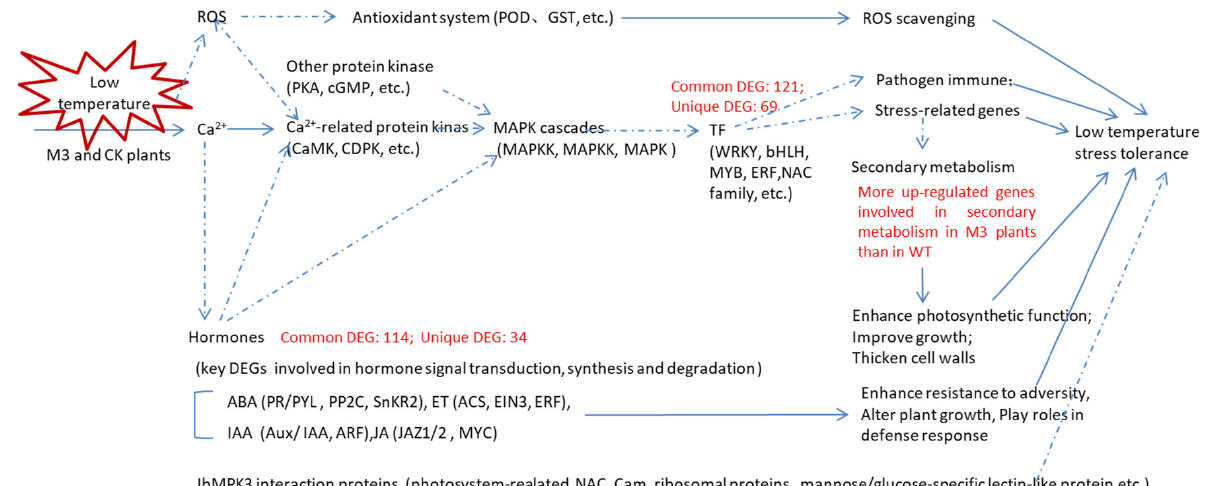
Figure 12. Hypothetical schematic model showing the mechanism in WT and M3 plants against low-temperature stress. This model was developed by combining the results of the RNA-seq analysis with previously described schemes of plant abiotic stress response networks. Blue lines with arrows denote a certain regulation; and blue dotted lines with arrows denote an uncertain regulation. The various crosstalk and feedback of multiple pathways, such as the hormone signaling pathway, ROS signaling pathway, and secondary metabolic pathway, as well as the genes encoding TF families and stress-related genes are assumed to respond to low-temperature stress.